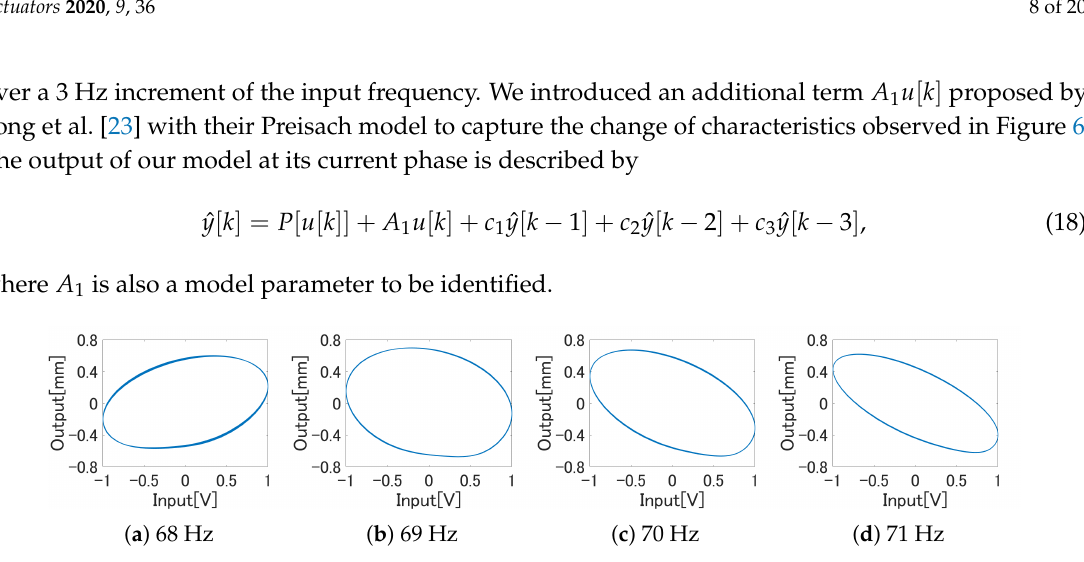
Figure 6. Four hysteresis loops observed around the resonance frequency.